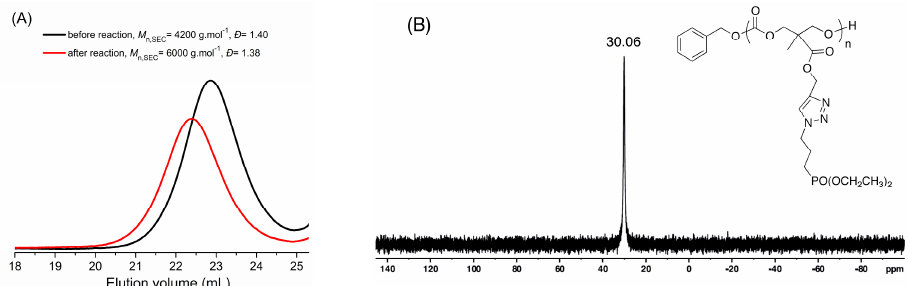
Figure 5. ( A ) Overlaid SEC traces of poly(MPC) 46 before and after the “click” reaction; ( B ) 31 P NMR spectrum of poly(MPC) 46 after the “click” reaction in acetone D 6 .